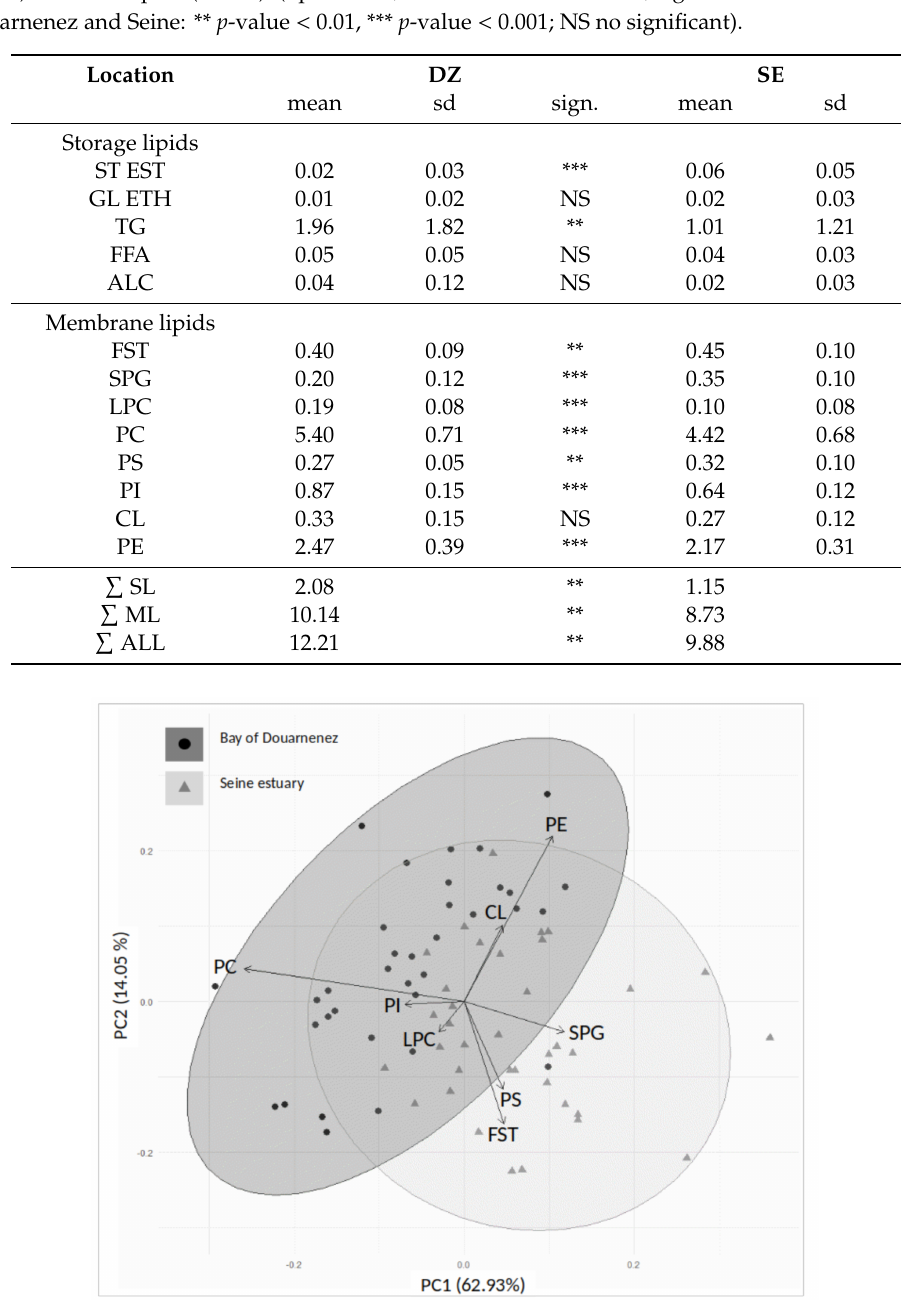
Table 3. Muscle lipid content expressed as µ g of lipid per milligram of fresh weight (storage lipids and